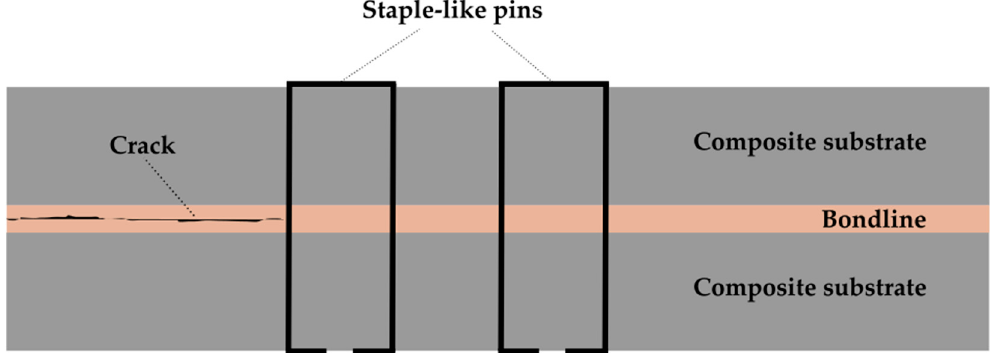
Figure 8. The concept of staple-like pins installed at the bonded substrates.